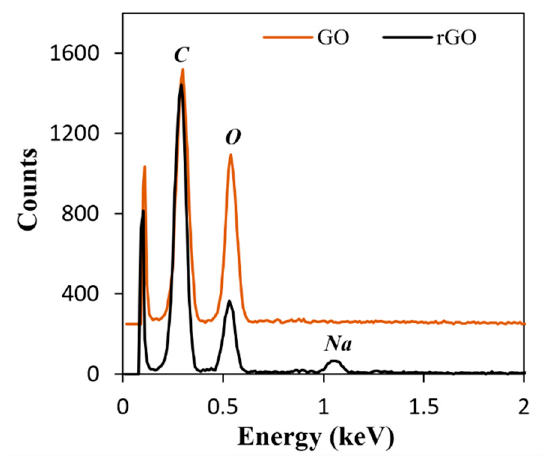
Figure 9. EDX spectra of GO and rGO synthesized using lemon juice (the peak at 0.1 keV is peak originating from background).